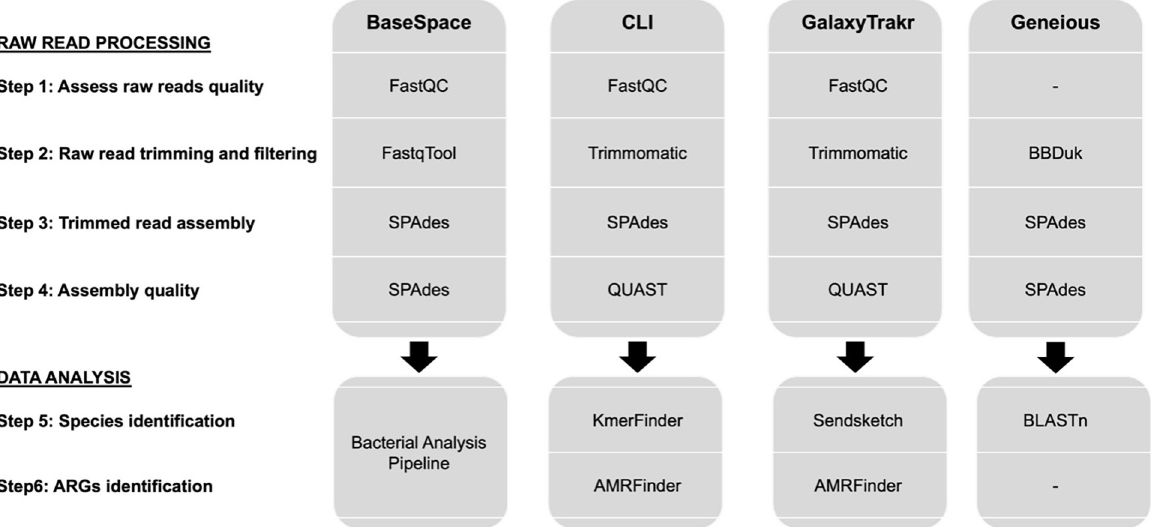
Fig 1. Summary of the steps and software used for data analysis in each bioinformatics